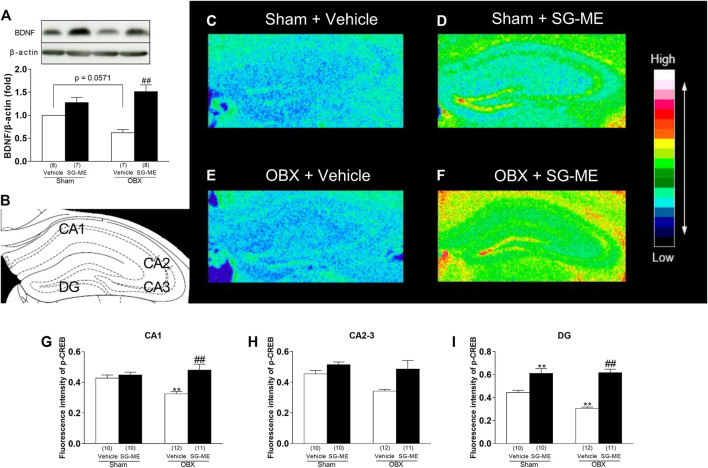
Increased BDNF and p-CREB levels in the hippocampus after SG-ME administration. Representative immunoblots probed with antibodies against hippocampal BDNF and β-actin, as indicated. Quantification of values for BDNF normalized with β-actin levels in the hippocampus (A). Distribution of the immunohistochemical fluorescence intensity for p-CREB in the mouse hippocampus: diagram showing the hippocampal CA1, CA2, CA3, and DG areas (B); pseudocolor images for (C) Sham + vehicle; (D) Sham + SG-ME; (E) OBX + vehicle; (F) OBX + SG-ME with corresponding intensity values (arbitrary units) for p-CREB in CA1 (G), CA2-3 (H), and DG (I). Bars represent means ± SEM. Numbers in parentheses indicate the number of animals in each group. *: p < 0.05 and **: p < 0.01 vs. vehicle-treated sham group. #: p < 0.05 and ##: p < 0.01 vs. vehicle-treated OBX group.